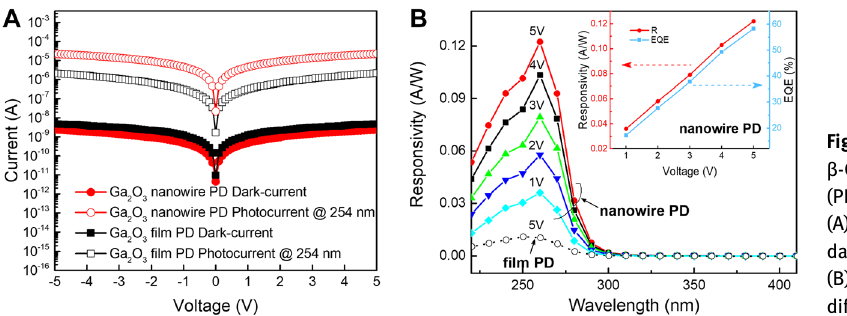
Figure 3: Photoelectric properties of β -Ga fi lm photodetectors 2 O 3 nanowire and (PDs). (A) I – V characteristics of PDs measured in dark and under 254 nm light illumination. (B) Spectral responses of PDs measured at different bias voltage.